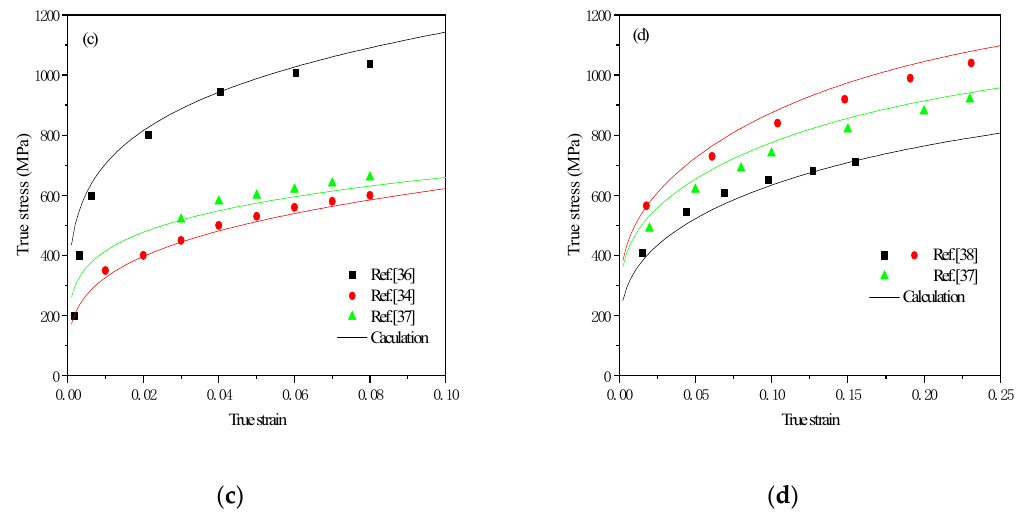
Figure 1. Figure 1. Calculation results and experiment results: ( a ) Ferrite; ( b ) Ferrite–Martensite; ( c ) Ferrite–